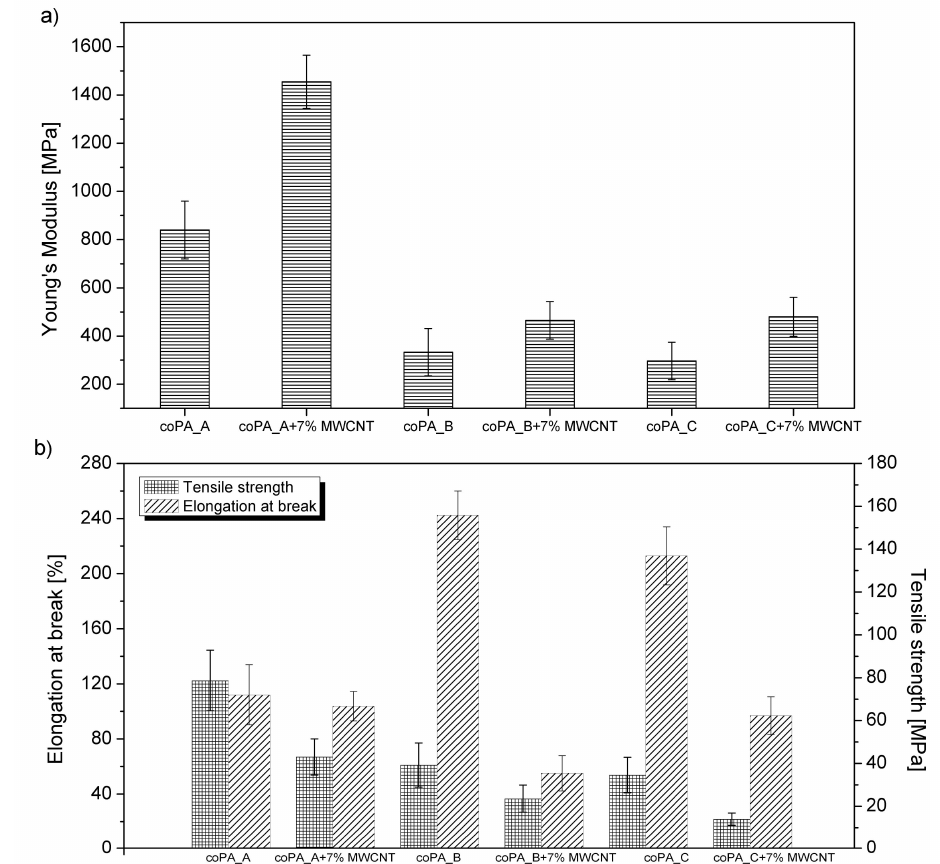
Figure 9. Comparison of mechanical properties of produced fibers ( a ) Young’s modulus; ( b ) tensile strength, and elongation at